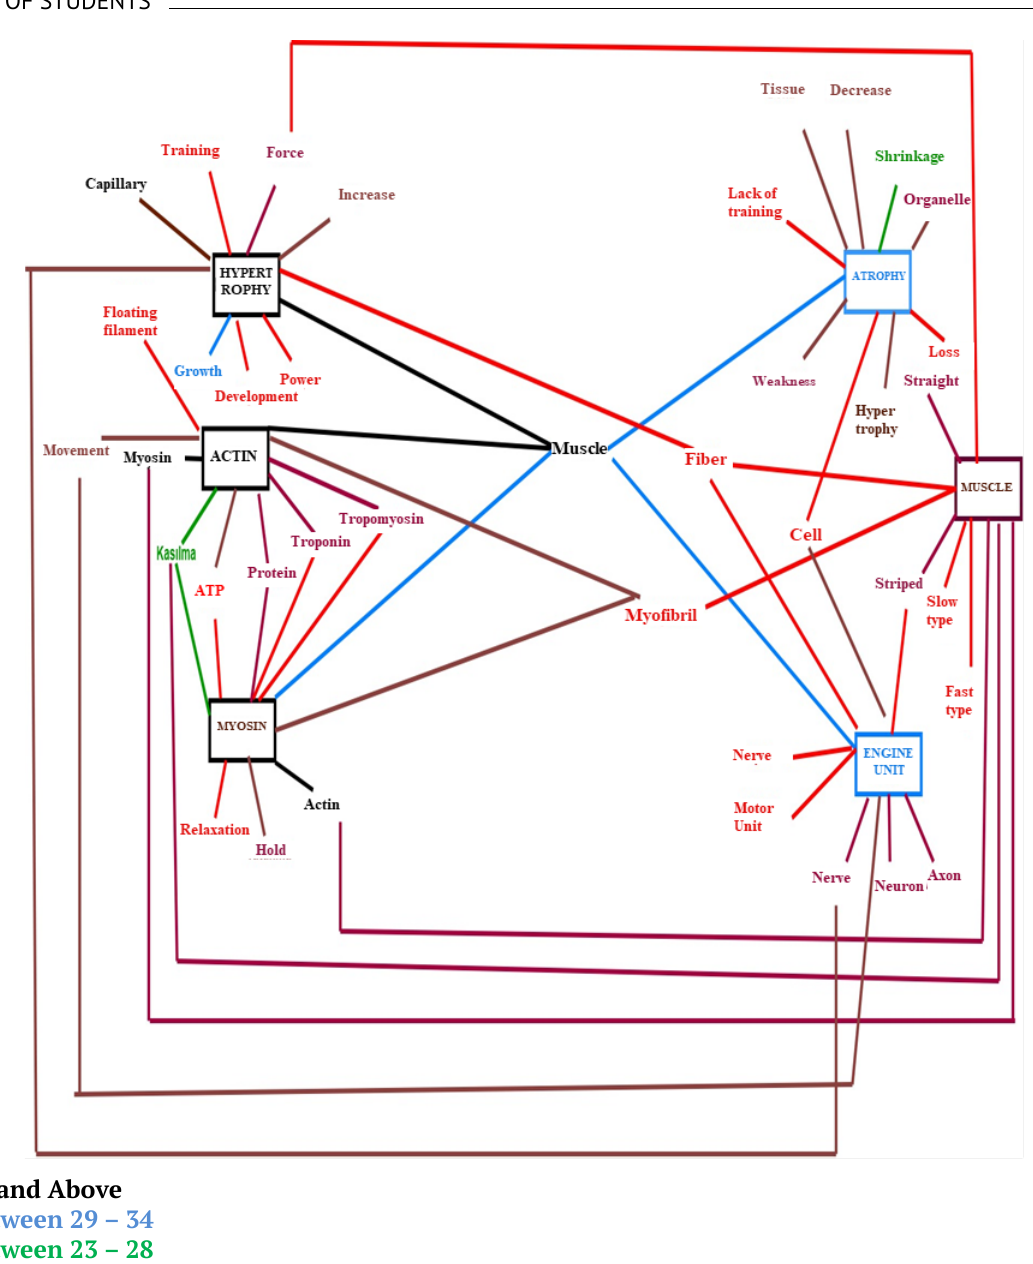
Figure 5. Concept Network Created by Second Group Keywords